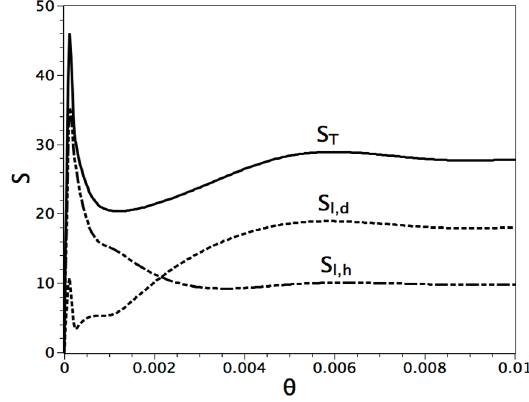
Figure 9. Entropy generations with no phase change (problem in Figure 1a) for Pr 50 = and 5 Ra 10 = .